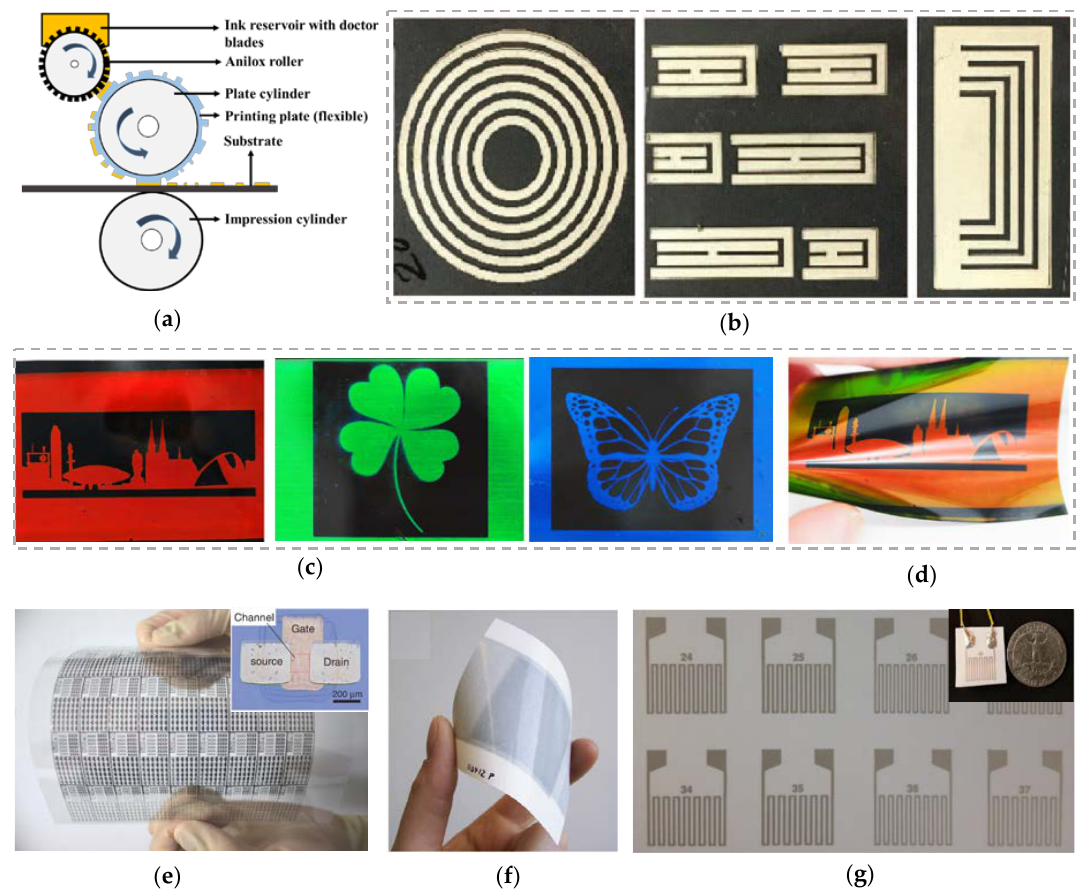
Figure 5. ( a ) Schematic of flexography printing process; ( b ) flexible chip less RFID tags (5-bit ring resonator tag (34 × 34 mm 2 ), 3-bit UH-strip tag (30 × 30 mm 2 ) and 4-bit U-slot tag (34 × 16 mm 2 )) [138],